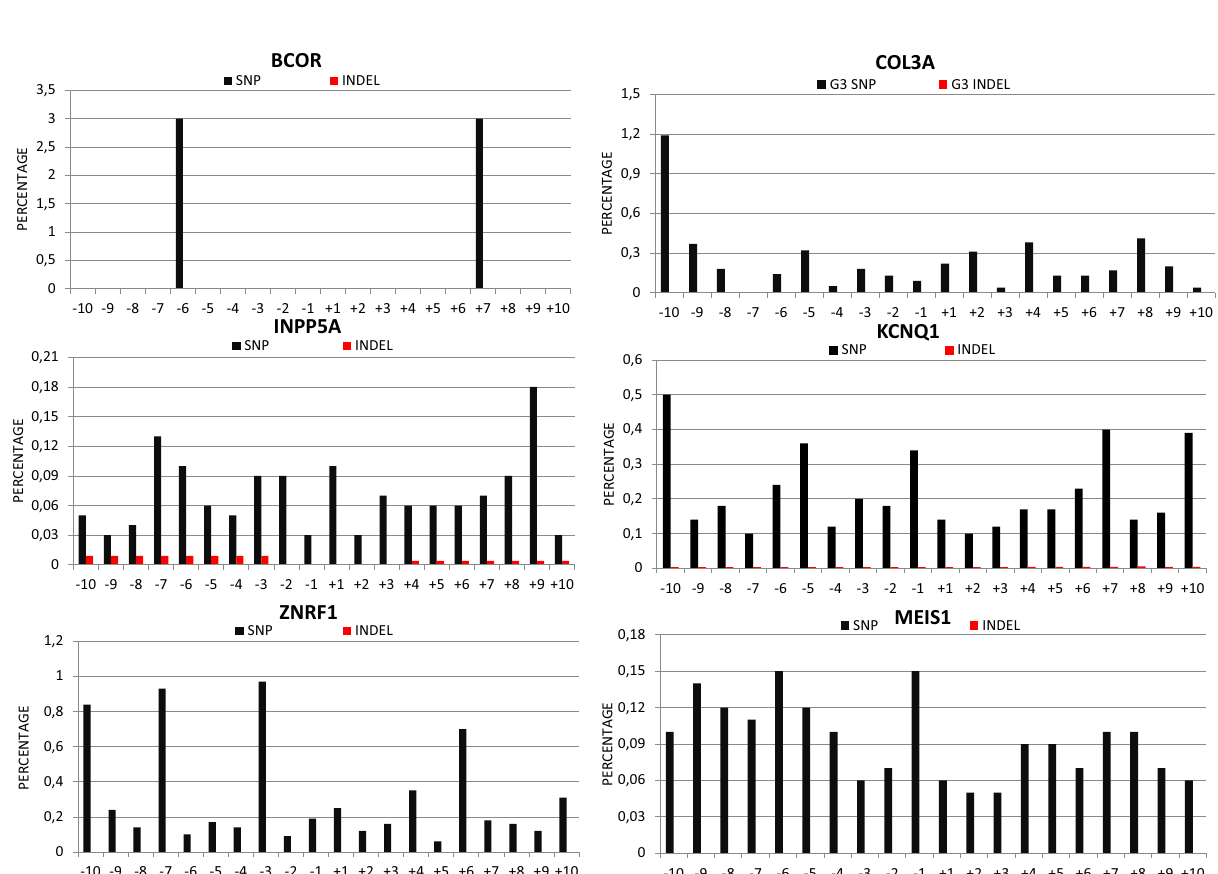
Figure 8. Off-target NGS analysis . Graphs represent the SNPs and indels percentages related to the region between 10 nt upstream and 10 nt downstream of the predicted G3 and G8 off-target cutting